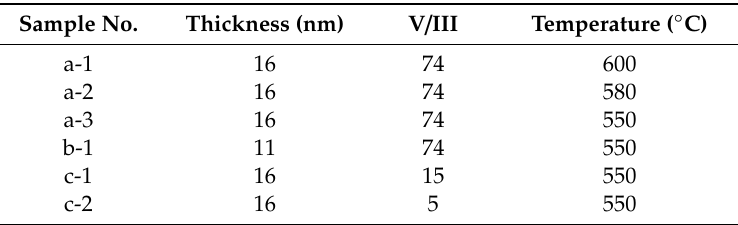
Figure 2. Schematic of tunnel-junction structure. The growth conditions of the InGaAs layer are summarized in Table 1. Table 1. Summary of growth conditions for In 0.07 GaAs layer.